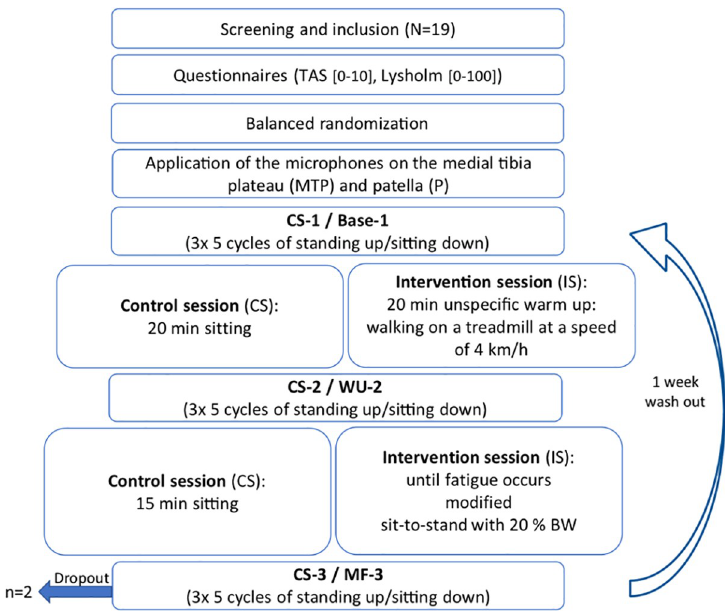
Fig 1. Study protocol. WU: warm up; MF: muscle fatigue; TAS: Tegner Activity Scale; BW: body weight.